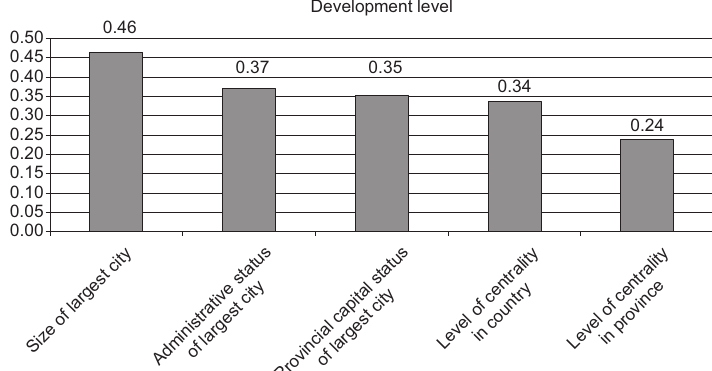
Fig. 4. Mean values of the Pearson correlation coefficients between independent variables and development levels for the years 2005 and 2015* (DepVar 1). *2008 and 2016, respectively, in specified cases. Source: own elaboration.